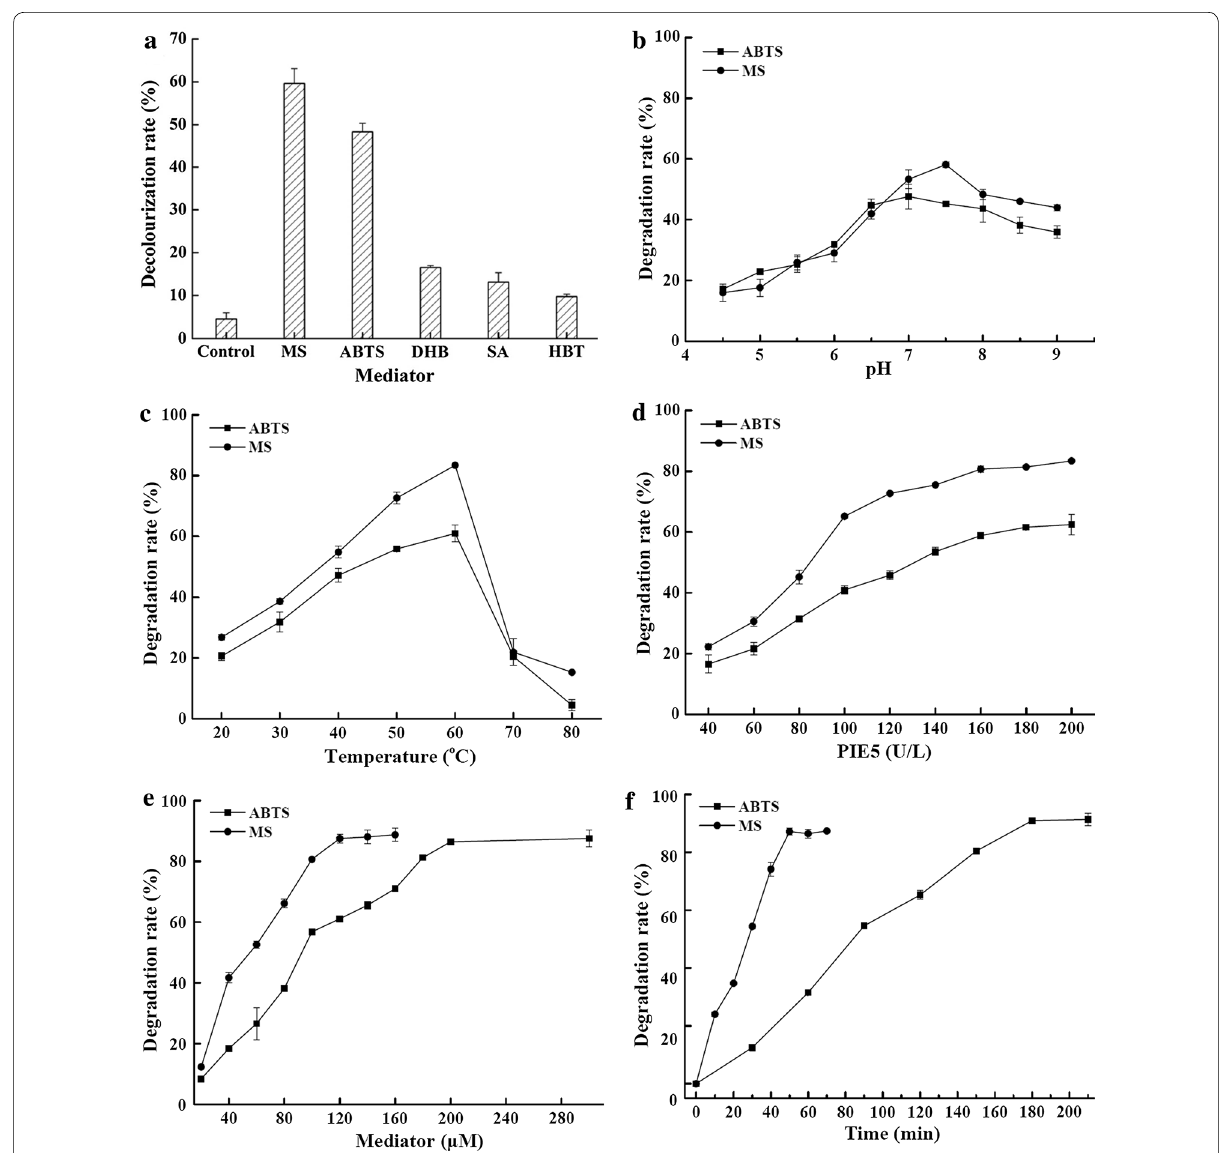
Fig. 4 Indigo dye decolorization condition optimization by PIE5. a Mediator type, b pH, c temperature, d PIE5 dosage, e mediator dosage, f incubation time. The data presented are the average values from triplicate technical repeats of measurements (n